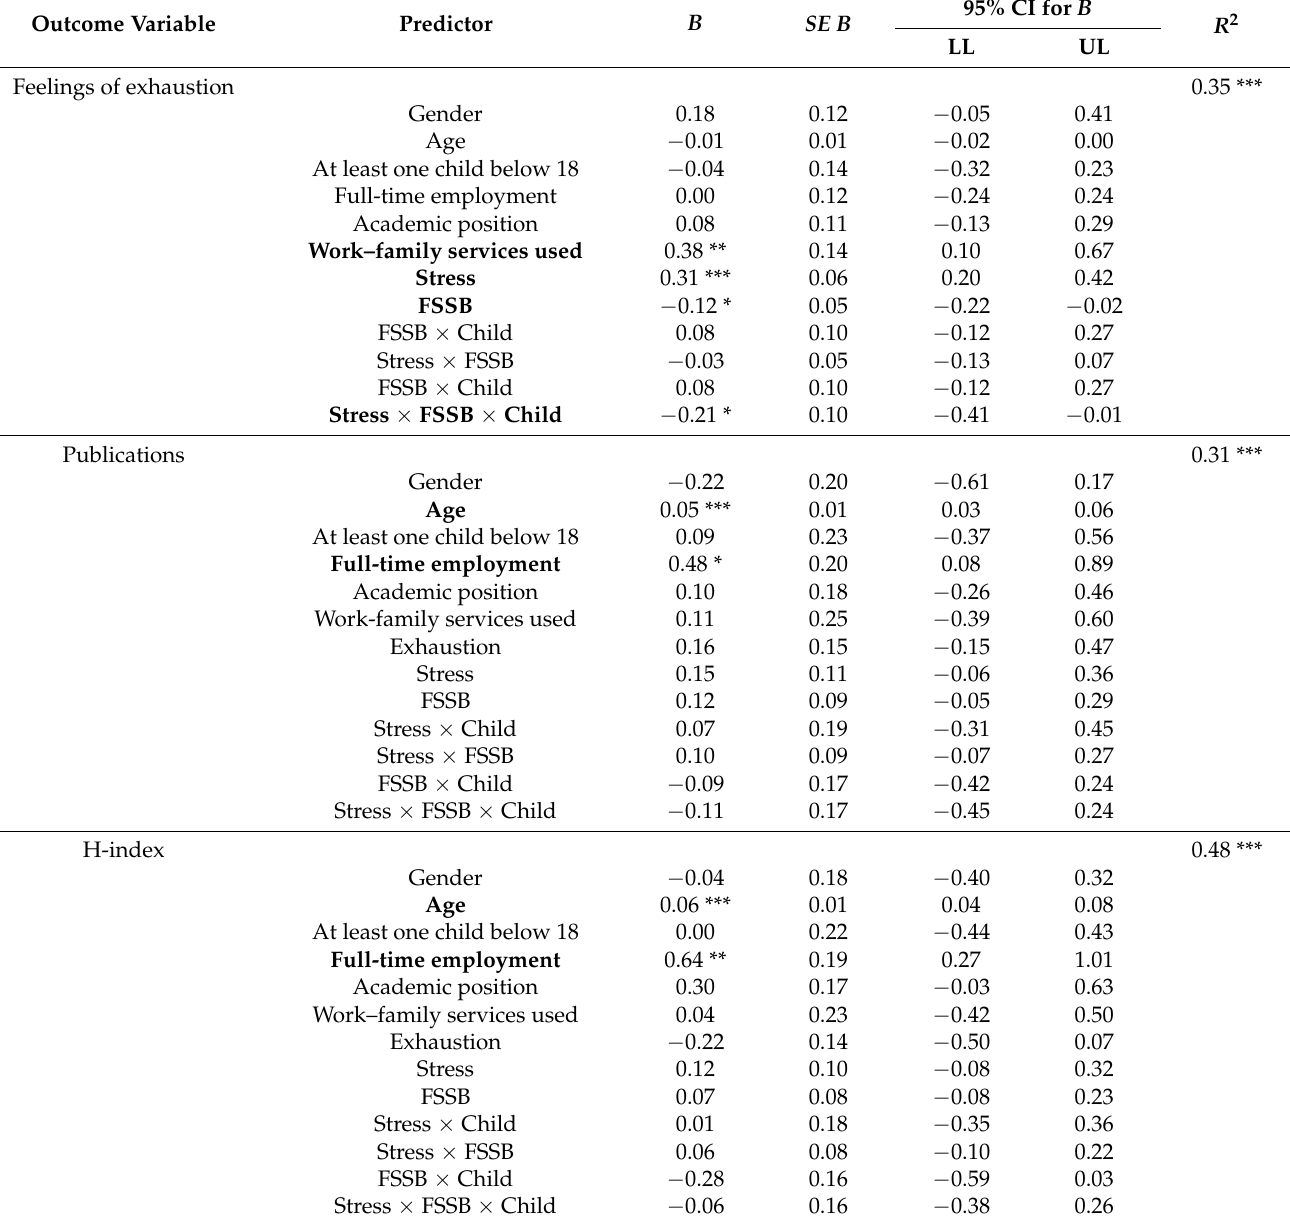
Table 4. All model path coefficients—direct